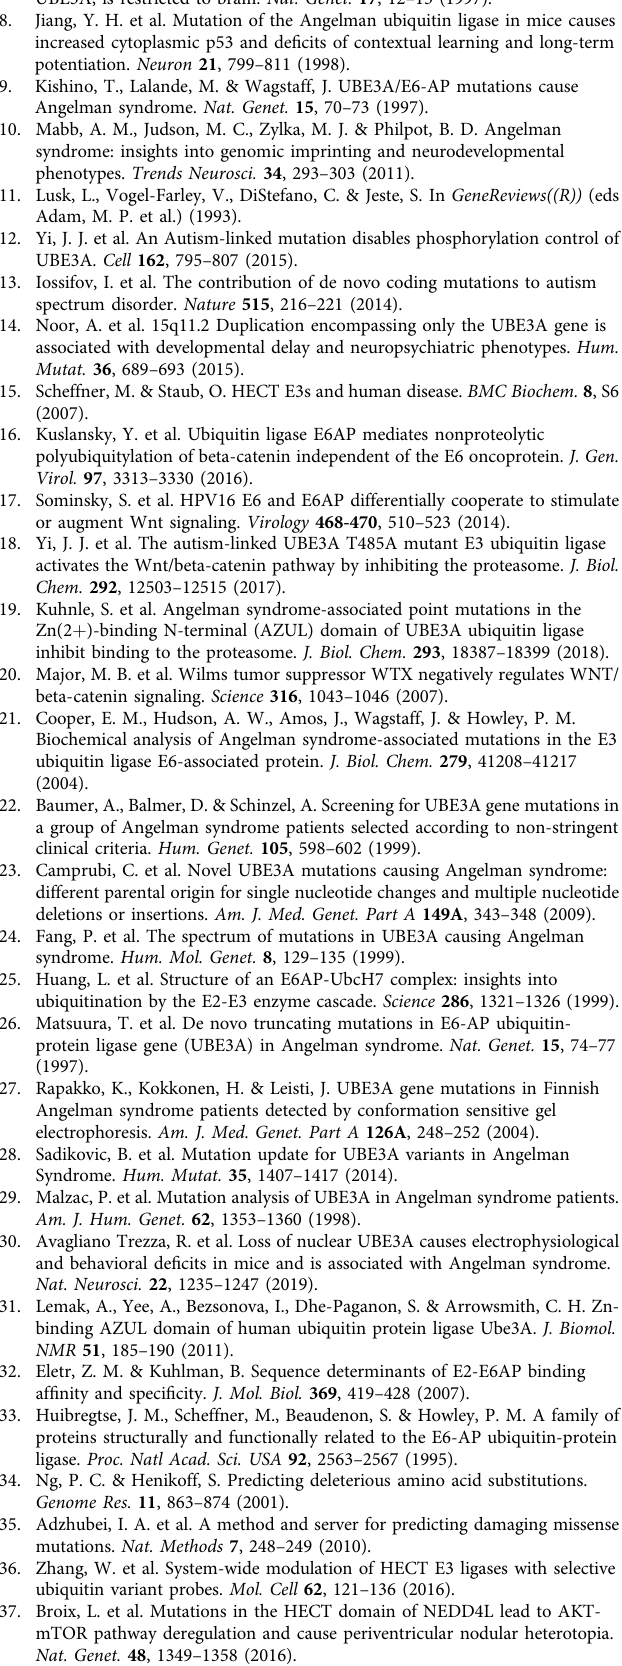
Figure 5a. One-sample t -test (two-tailed) with Benjamini – Hochberg multiple comparisons correction (false discovery rate = 0.05). * p <0.05, ** p <0.005, *** p < 0.0005. Figure 5f. Tukey ’ s multiple comparison test detected a signi fi cant interaction between WT UBE3A× Q588E: q = 8.580, p < 0.001, and between WT UBE3A× Q588R: q = 7.004, p <0.001. Figure 6c, d. Pearson Chi-square test, exact signi fi cance (two-sided). * p <0.05, ** p < 0.005, *** p < 0.0005. Figure 6e, f. Mann – Whitney U -test, exact signi fi cance (two-tailed). * p <0.05, ** p < 0.005, *** p < 0.0005. Figure 6h – k. Mann – Whitney U -test, exact signi fi cance (two-tailed). * p < 0.05, ** p < 0.005, *** p < 0.0005. Figure 6l. Repeated measures ANOVA. * p < 0.05, ** p < 0.005, *** p <0.0005. Figure 6m. Univariate linear mixed model. * p <0.05, ** p <0.005, *** p < 0.0005. Supplementary Fig. 1b. One-sample t -test (two-tailed) with Benjamini – Hochberg multiple comparisons correction (false discovery rate = 0.05). * p <0.05, ** p <0.005, *** p <0.0005. Supplementary Fig. 2b. One-sample t -test (two-tailed) with Bonferroni multiple comparisons correction (critical vale = 0.05). Mutant enzyme protein levels were normalized to WT UBE3A and tested for deviance from a theoretical mean abundance level of 100. * p <0.05, ** p < 0.005. Supplementary Fig. 2e. One-sample t -test (two-tailed) with Bonferroni multiple comparisons correction (critical value = 0.05). RING1B protein levels for each UBE3A mutant-transfected sample was normalized to WT UBE3A and tested for deviance from a theoretical mean abundance level of 100. * p <0.05, ** p <0.005. Supplementary Fig. 3d. One-sample t -test (two-tailed) with Benjamini – Hochberg multiple comparisons correction (false discovery rate = 0.05). * p <0.05, ** p <0.005, *** p <0.0005. Supplementary Fig. 5c, f. Mann – Whitney U -test, exact signi fi cance (two-tailed). * p < 0.05, ** p < 0.005, *** p < 0.0005. Supplementary Fig. 5g – l. Univariate linear mixed model. * p < 0.05, ** p < 0.005, *** p < 0.0005. All behavioral statistical analyses were performed in SPSS (v.27). ANOVA assumption of normality was assessed by using the Shapiro – Wilks test and manual assessment of the z -score histogram plot outputs. Mice that had a value greater than 3.29 standard deviations above the mean were deemed in fl uential outliers